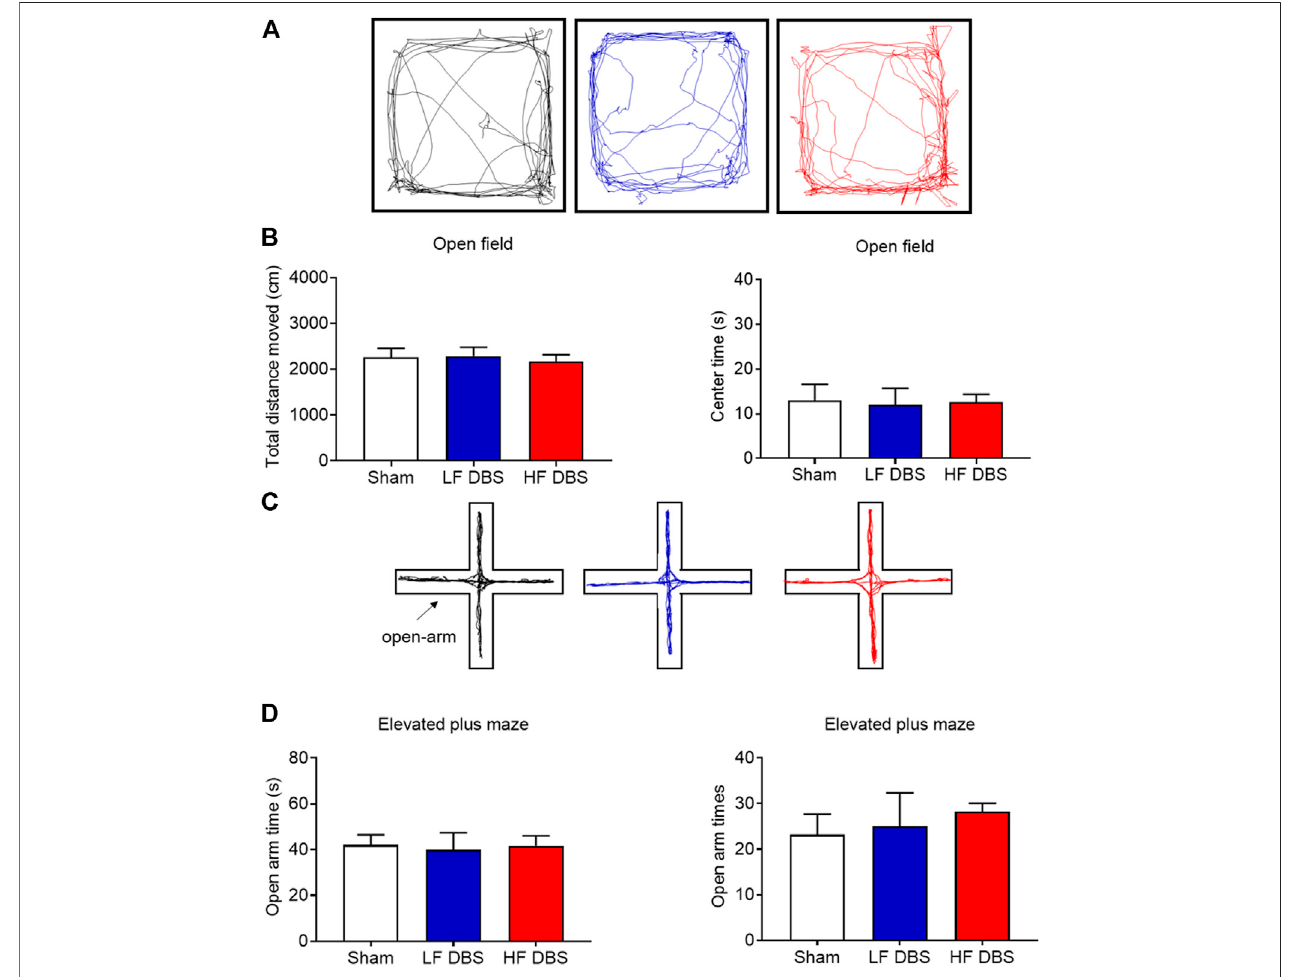
FIGURE 4 | DBS of the SNr did not affect locomotor activity and anxiety-like behavior. (A) Representative activity traces of sham, LF, and HF DBS groups in the open fi eldtest. (B) Totaldistancetraveledandtimeinthecentralzoneintheopen fi eldtest. (C) Representativeactivitytracesofsham,LF,andHFDBSratsintheelevated plus maze test. (D) Time and entries in the open arms of the elevated plus maze test. Data are shown as mean ± SEM. n (cid:2) 6 for all groups.